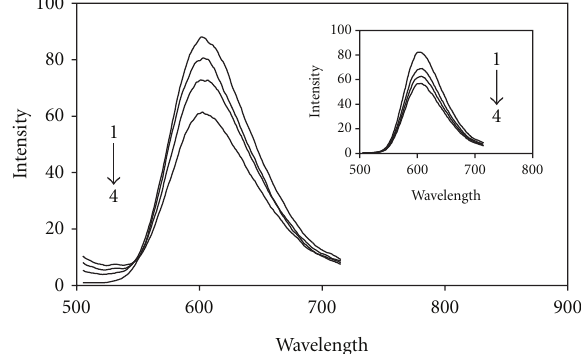
Figure 10: Fluorescence emission spectra of interacted EB-DNA in the absence (1) and presence of di ff erent concentrations of [Pt(bpy)(Oct-dtc)]NO 3 and the inset for [Pd(bpy)(Oct-dtc)]NO 3 : 33 μ M (2), 71 μ (3), and 111 μ M (4) and 12 μ M (2), 35 μ M (3), and 55 μ M (4), respectively, at 300